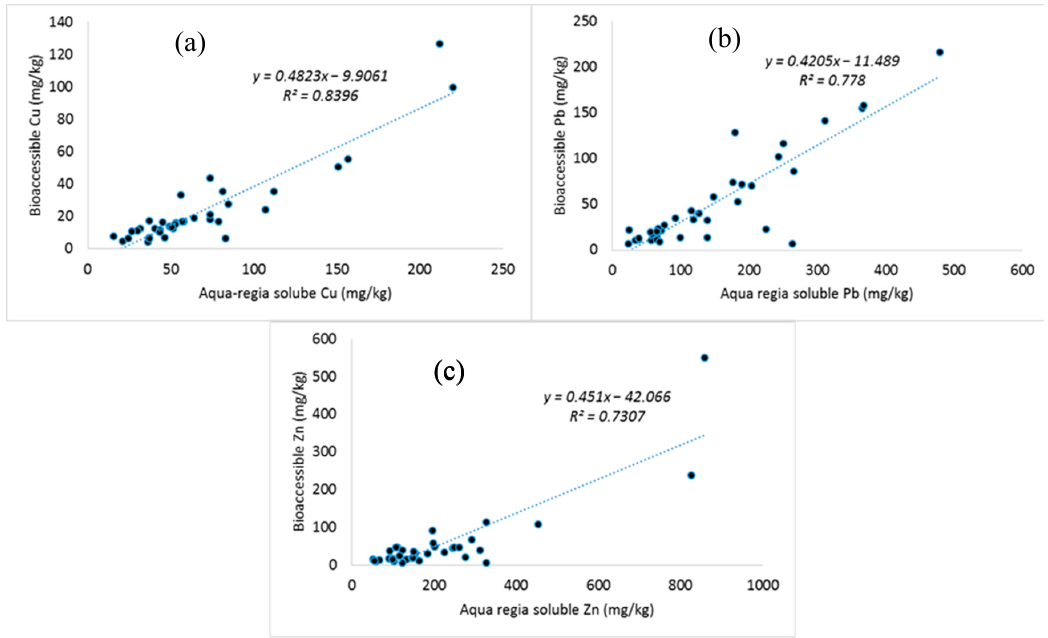
Figure 3. Relationships between pseudototal (aqua regia soluble) PTE and bioaccessible PTE concentrations for copper ( a ), lead ( b ) and zinc ( c